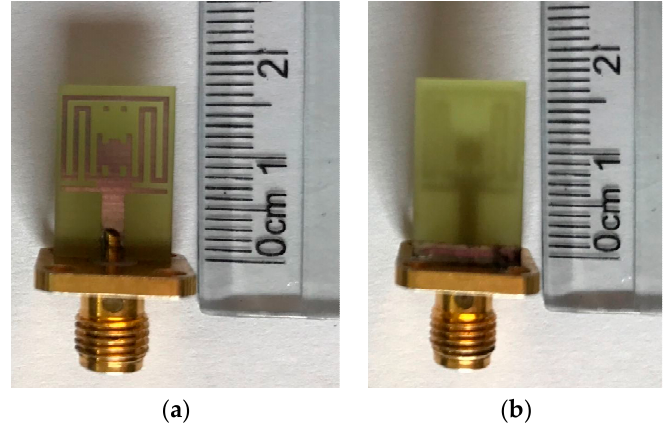
9 of 17 Figure 9. Simulated S 11 results for the antenna as a function of l 5 , the vertical length of the comb- shaped slot. 3. Experimental Results and Discussions 3.1. Frequency-Domain Performance The prototype antenna with the optimal dimensions listed in Table 1 was fabricated and tested, as shown in Figure 10. Figure 11 presents the simulated and measured VSWR of the proposed antenna. The measured results are obtained by using an Anritsu 37347D vector network analyzer (40 MHz–20 GHz, Anritsu Corporation, Atsugi, Kanagawa, Japan). It can be seen that the simulated impedance bandwidth for VSWR <2 is 2.20–14.68 GHz, covering the entire UWB frequency band, except for triple-notched bands of 3.32–3.88, 5.0–5.36, and 5.52–5.92 GHz. The maximum simulated VSWR values in the triple-notched bands are 9.8 (at 3.64 GHz), 4.9 (at 5.16 GHz), and 3.9 (at 5.68